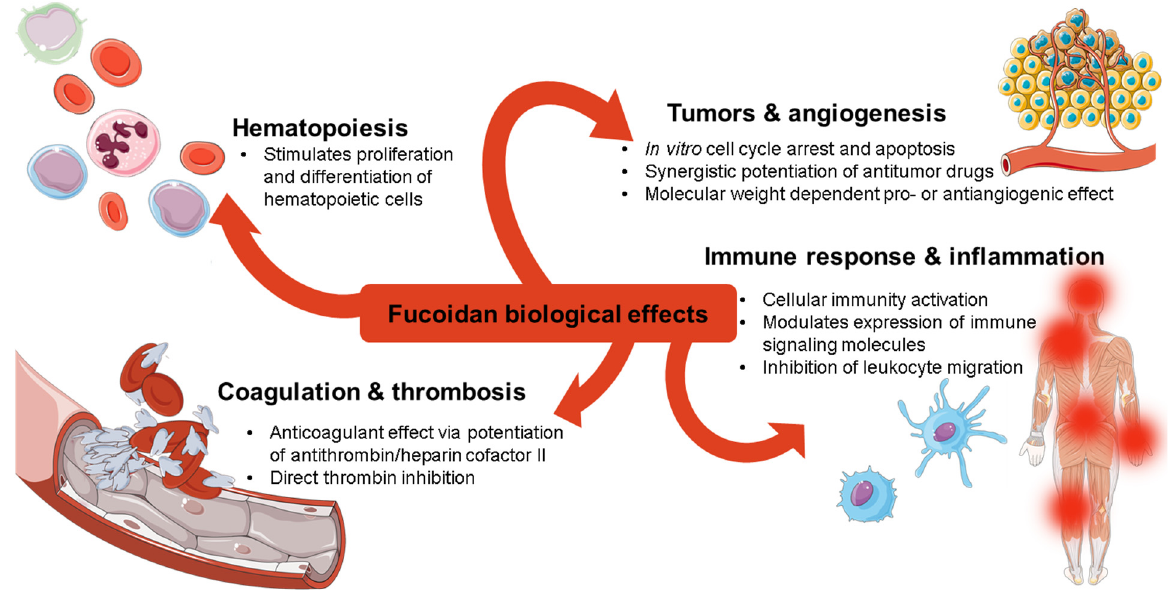
Figure 1. Main types of biological activities of fucoidans.